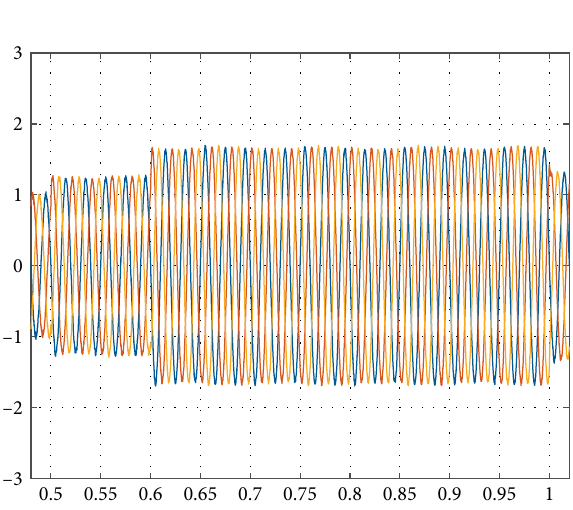
Figure 11: Stator voltages.